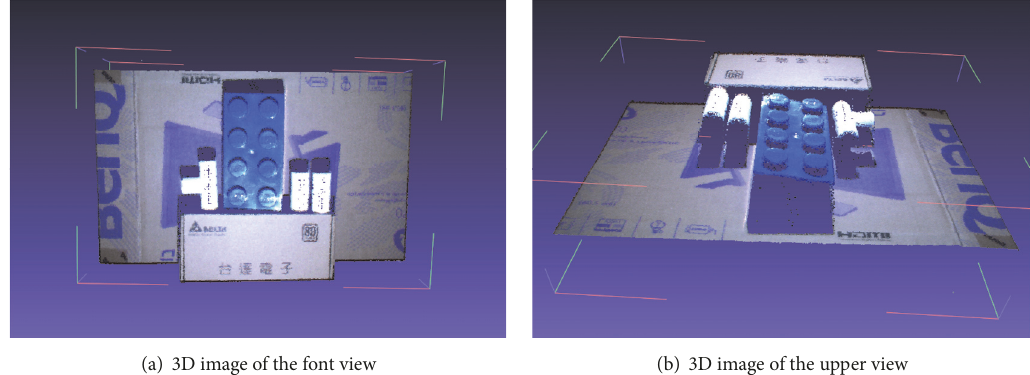
Figure 7: 3D reconstruction result with some objects (a lego box, three plastic pipes, and a big box), these objects are low reflecting light.